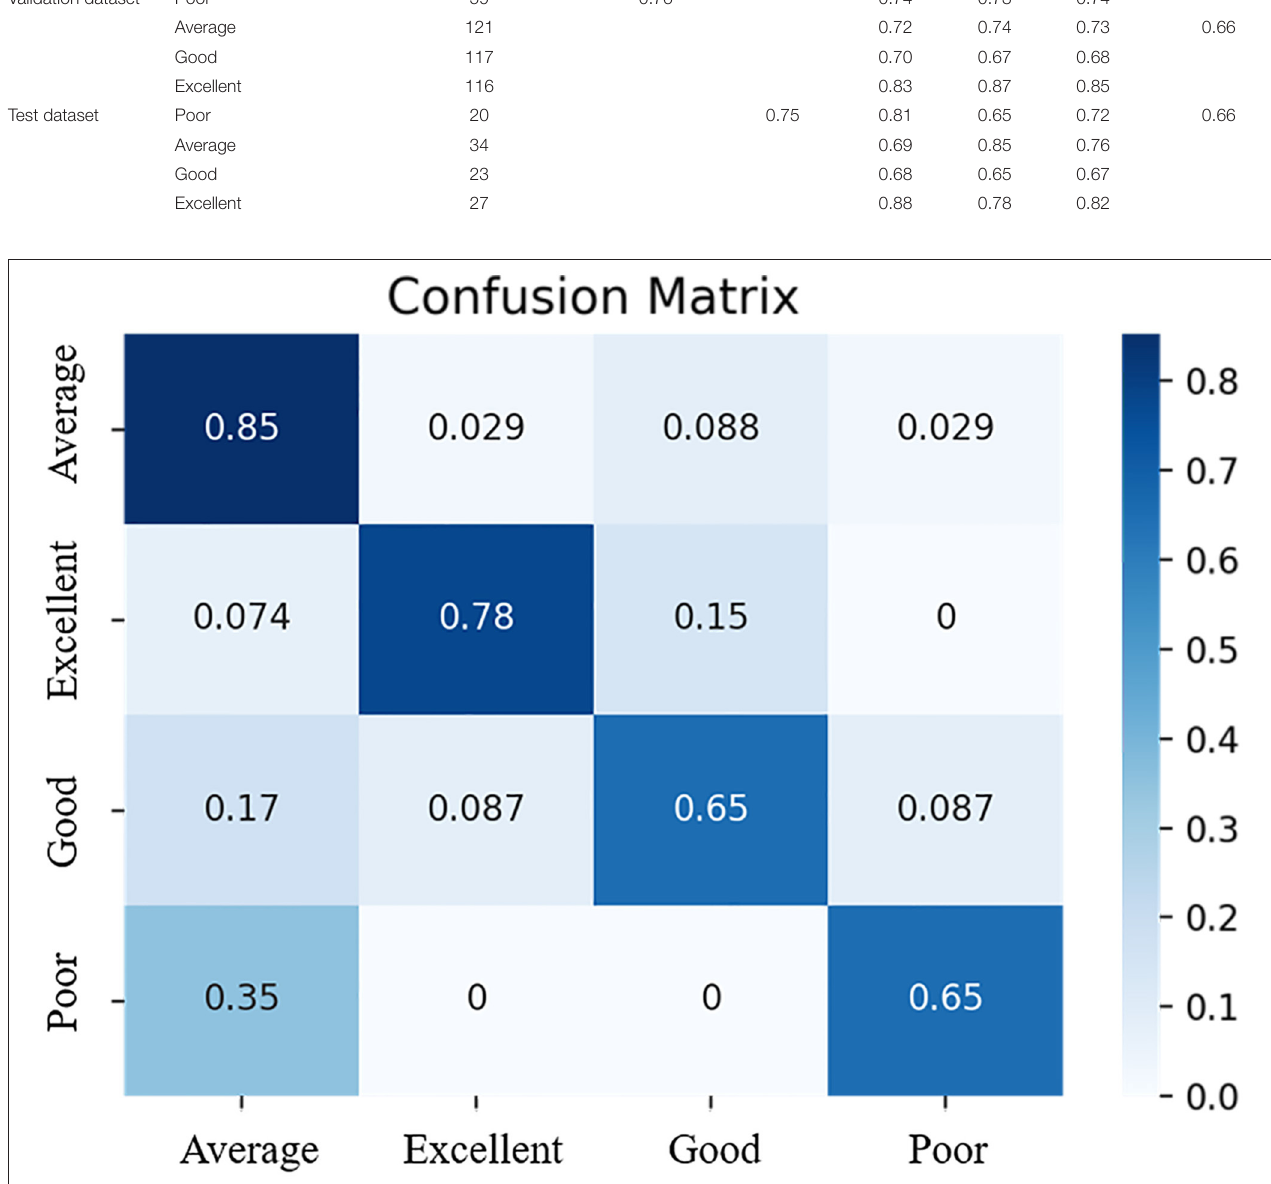
FIGURE 2 | Confusion matrix of the SVM classification model based on VO 2 max differences.